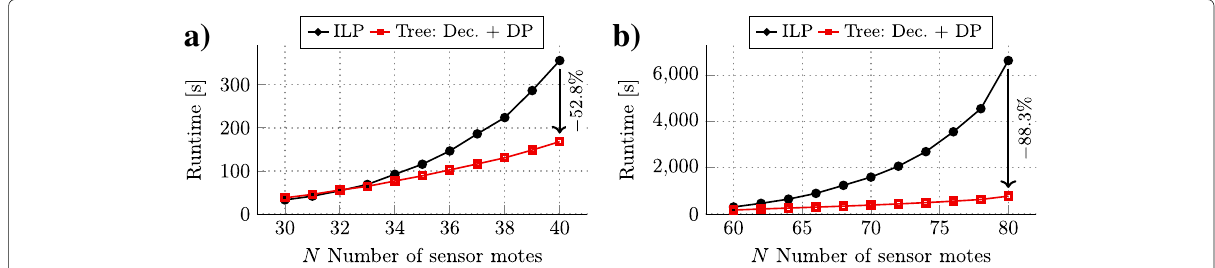
Fig. 7 Figures a and b show the total run times for 10 and 20 distinct DS-CDMA codes, respectively. Moreover, the measurement noise and sensing √ 2, respectively range has been set to σ = 0.05 and R =